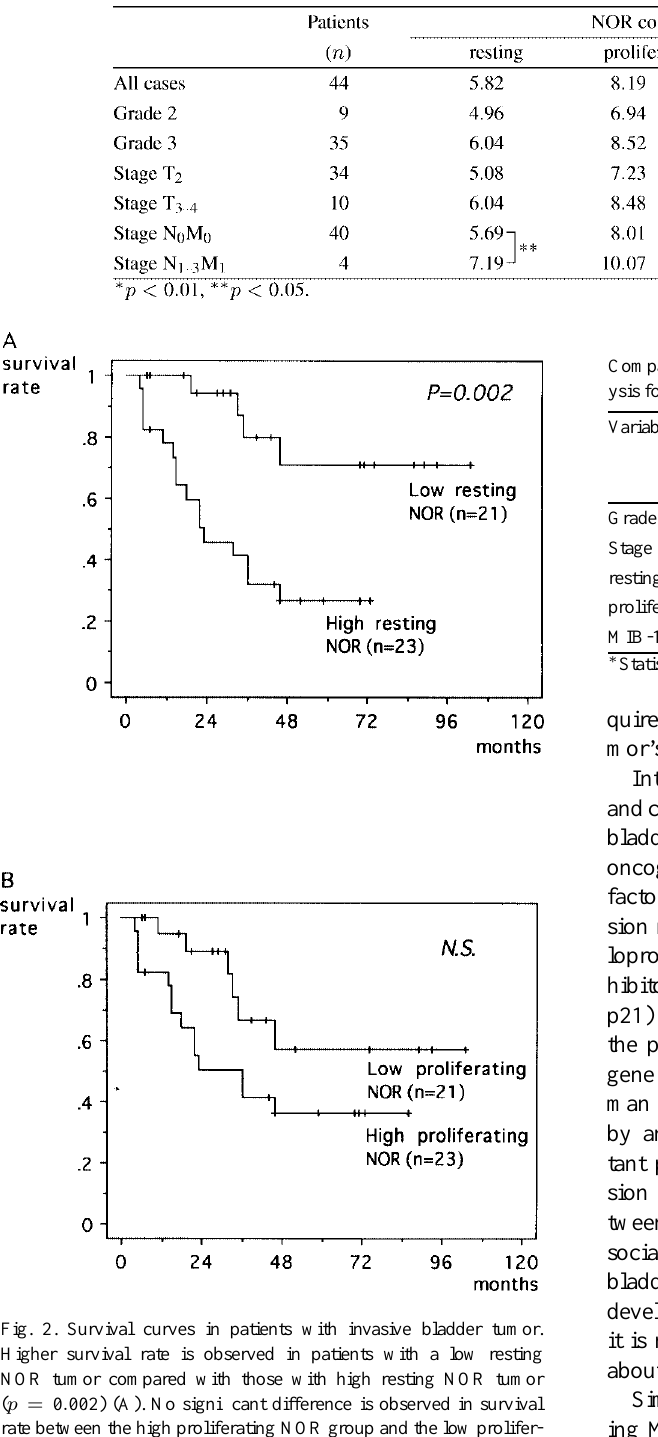
Correlation between pathological variables and NOR counts and MIB-1 LI